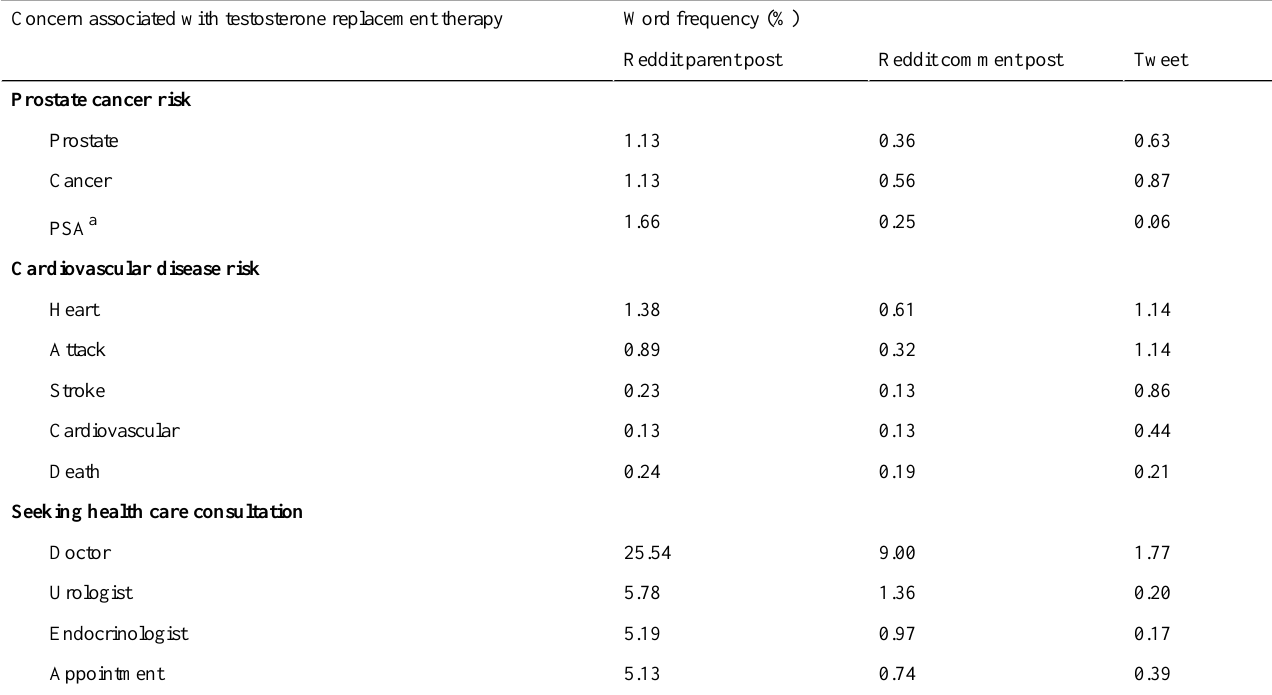
Table 5. Subset analysis of word frequencies related to prostate cancer risk, cardiovascular disease risk, and seeking a health care consultation.